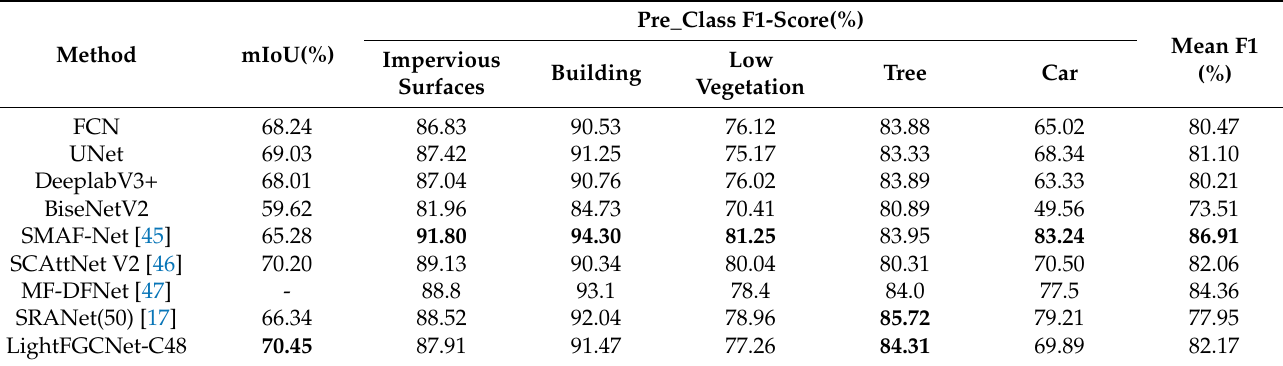
Table 7. mIoU, F1, and mean F1 on the Vaihingen dataset. The bold indicates the best data.